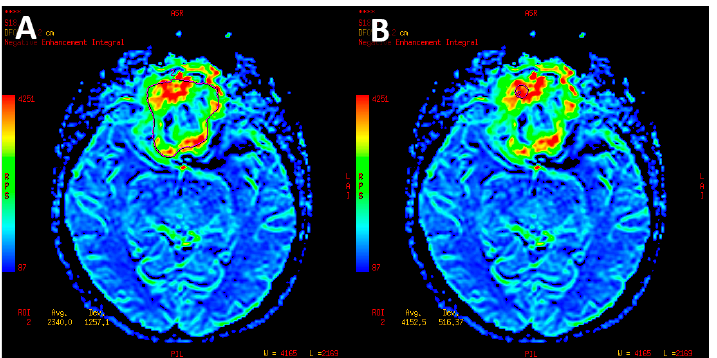
Figure 4. Meningioma with manually set region of interest outlining the tumor margins on axial slice used to measure mean CBV ( A ). Circular ROI about 58 mm 2 inserted in the hyperperfused part of lesion used to measure maximum CBV ( B ).